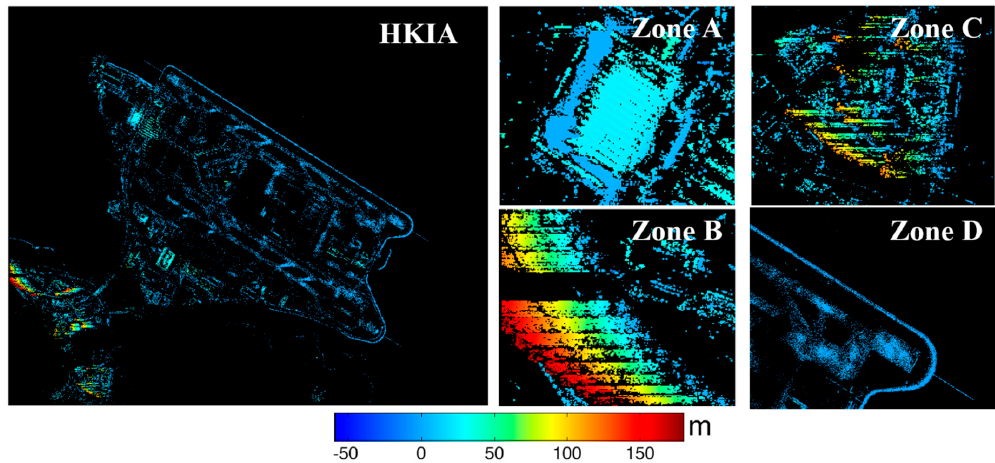
Figure 14. PS measurements detected under ˆ γ = 0.75, ( left ) the entire airport and ( right ) the four zones of A-D in Figure 9. Pixels are displayed in their height values for reflecting structure details.